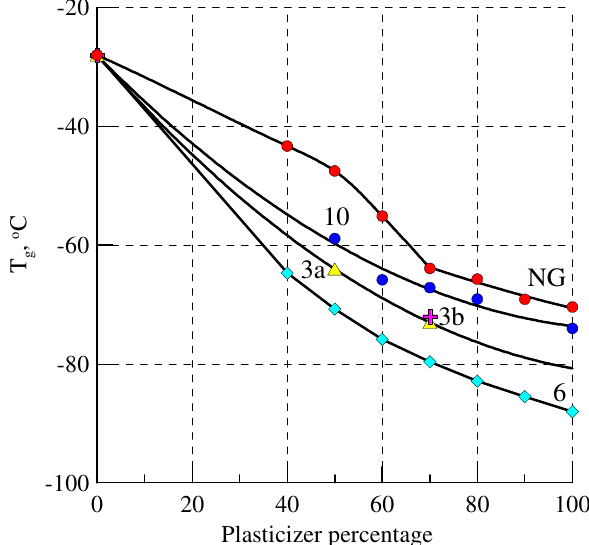
Figure 7. The effect of the percentage of plasticizer on the Tg of PU-based